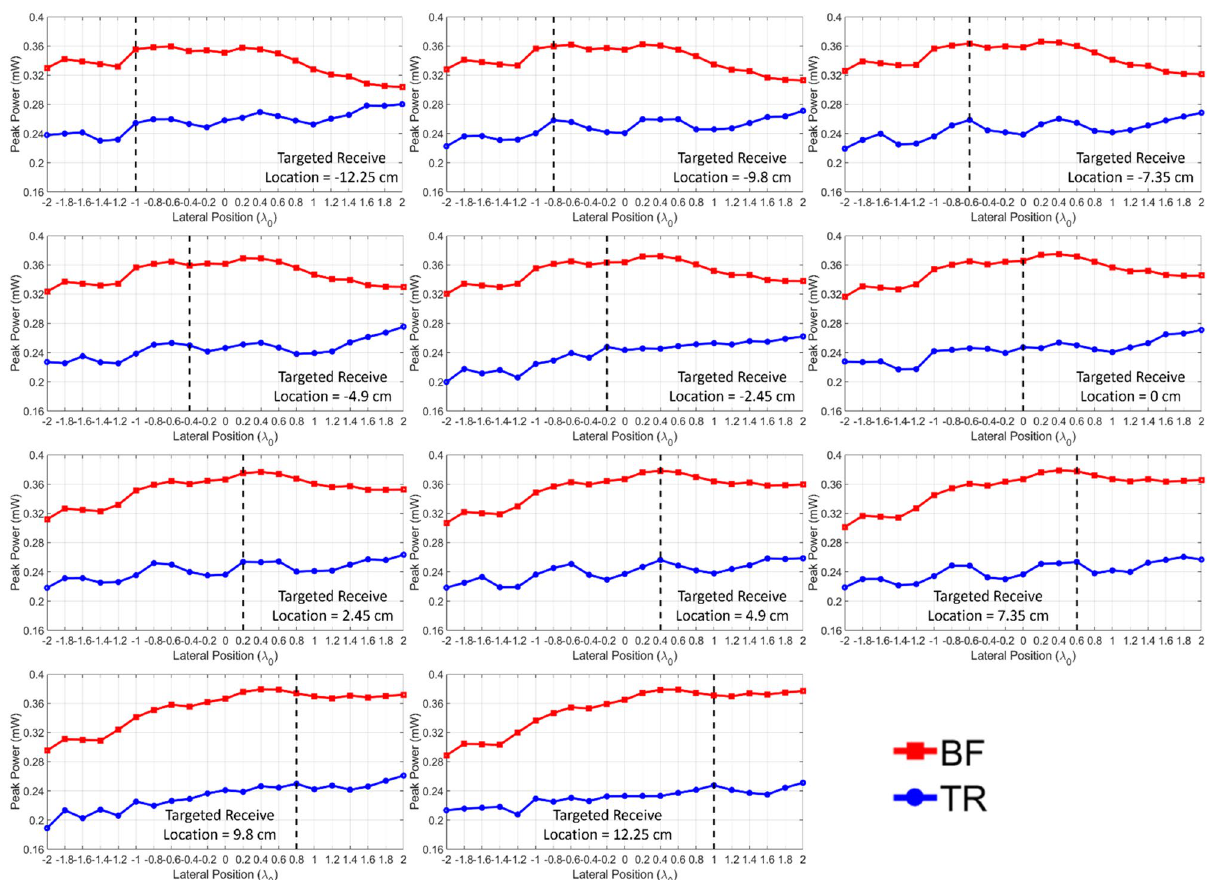
Figure 5. Measured peak power at the receiver as a function of lateral position resulting from BF and TR in free